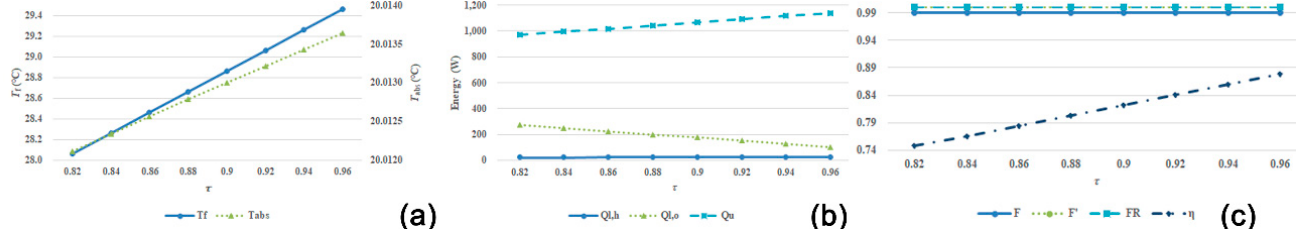
Figure 17. Influence of transparent cover transmittance ( τ ) . ( a ) Dependence between T f , T abs , and τ . ( b ) Dependence between energy, and τ . ( c ) Dependence between efficiency parameters, and τ .